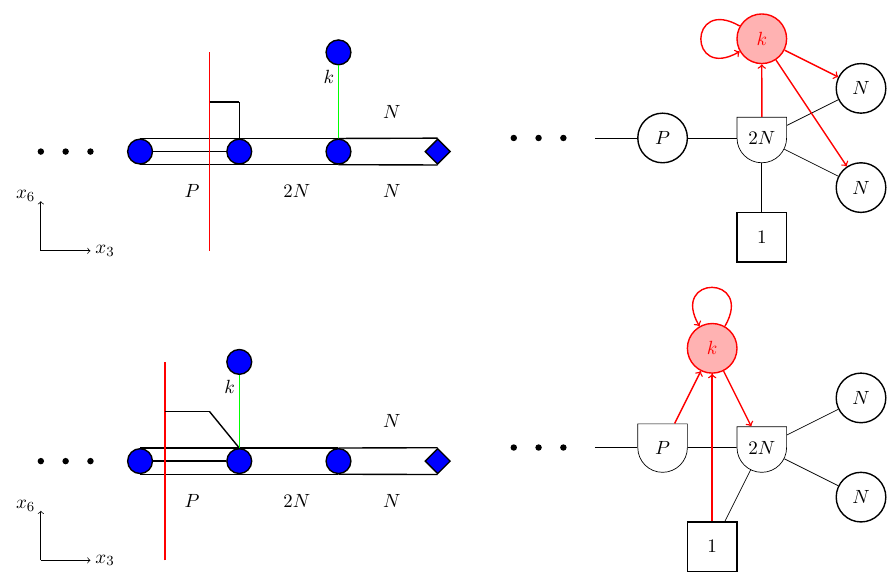
Figure 58 . Vortex defects for the U(2 N ) gauge group of the generic D -type quiver can be understood as the deformation of at least two 3d-1d coupled quivers. The two coupled quivers as well as the corresponding Type IIB realizations are